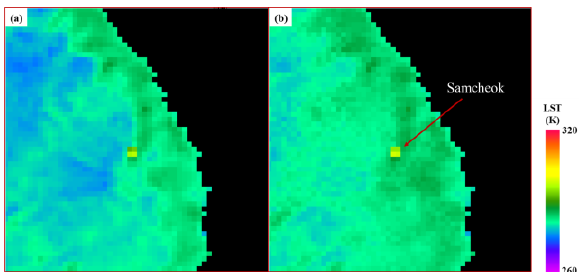
Figure 3. Before and after correction of height effect